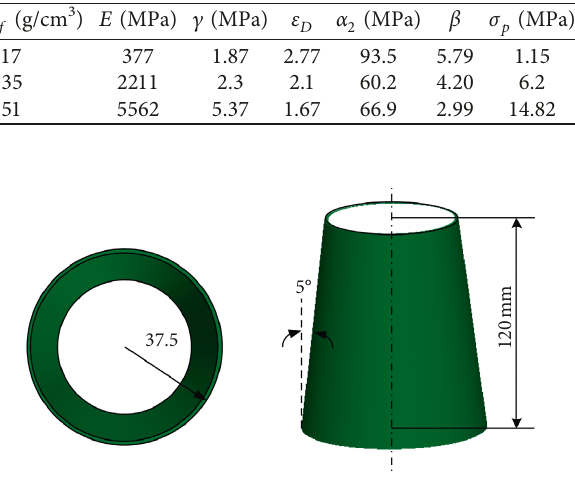
Figure 5: Geometric features of FTS.